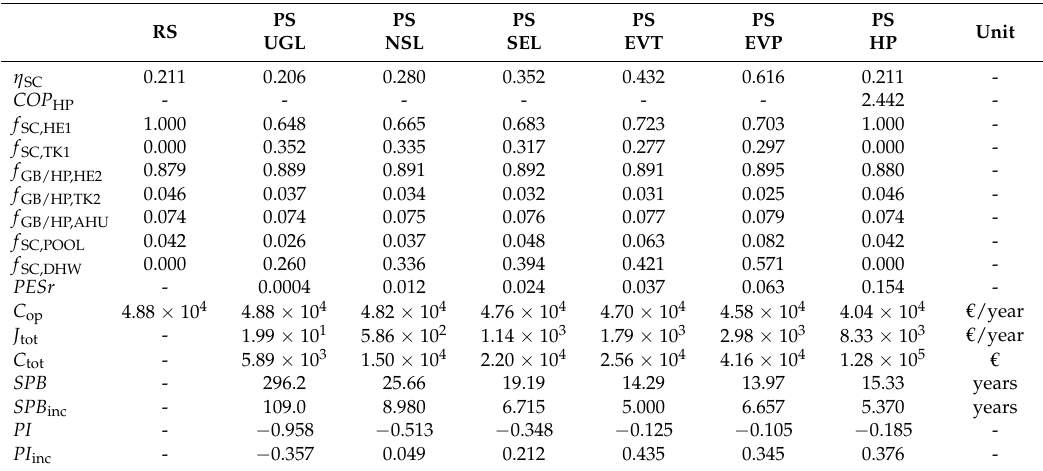
Table 8. Energy and economic performance parameters of the system, yearly